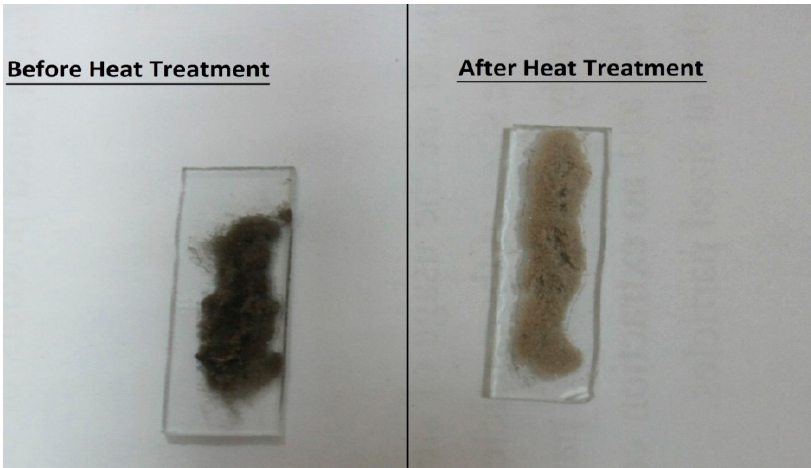
Figure 6. Film before and after heat treatment.